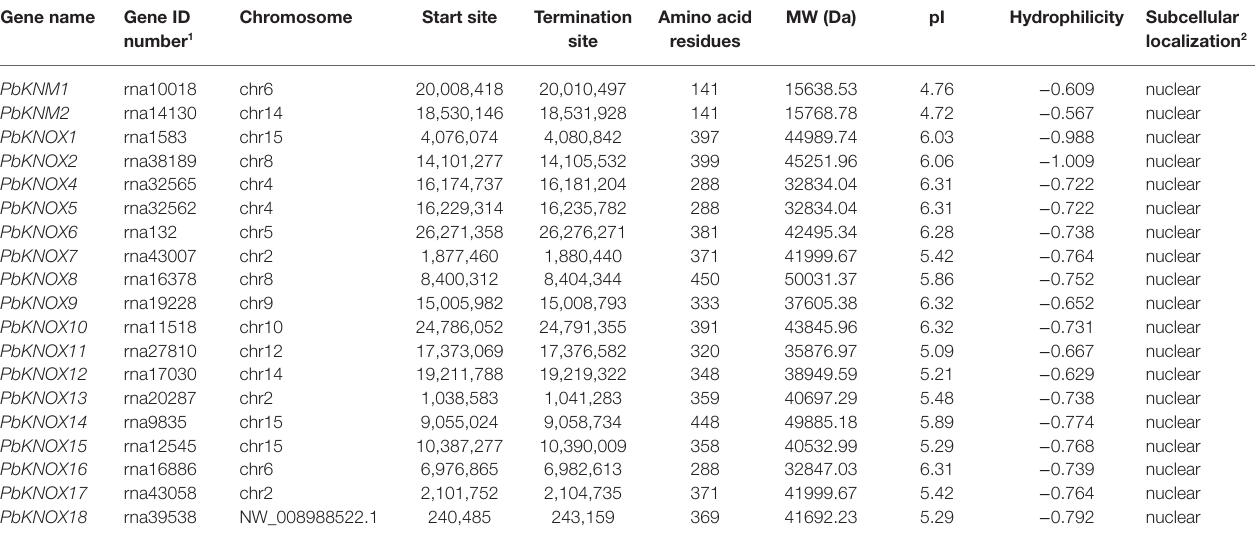
TABLE 1 | General information on Pyrus bretschneideri KNOX genes.